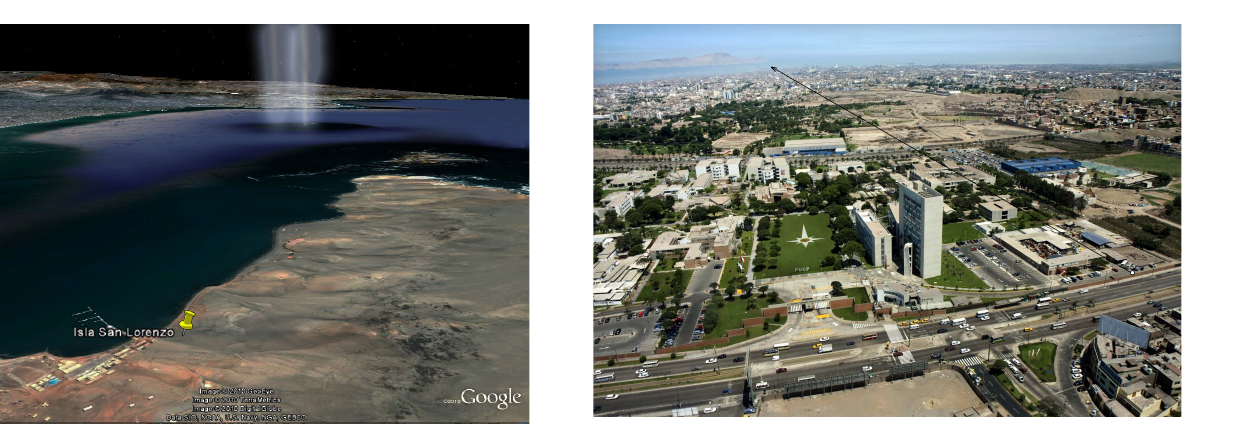
Fig. 4. The continental coast from “San Lorenzo” island, look- ing SSE. The witness was located by the pier, close to the yellow thumbtack. The image is a computer recreation approved by the witness. The striped light columns appeared to be coming out of the ocean but rocky islets have been identified in that area.